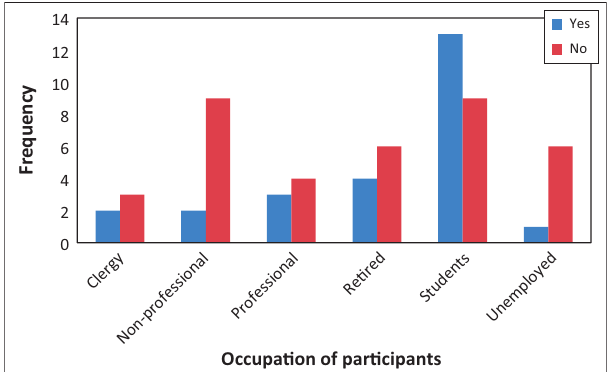
FIGURE 1: Distribution of occupation of participants showing the proportion of those who obtained their devices and those who did not obtain a low vision device ( N = 62). TABLE 2: Category of visual impairment. Category † Before low vision assessment